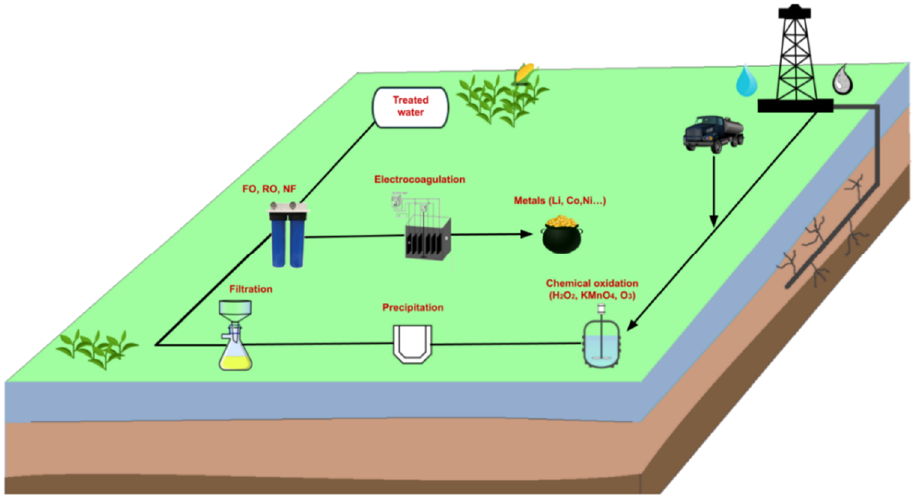
Figure 3. Schematic of the valorization process for FP. Step-by-step methodologies are applied to extract precious metals from FP, adding an aggregated value to this waste.